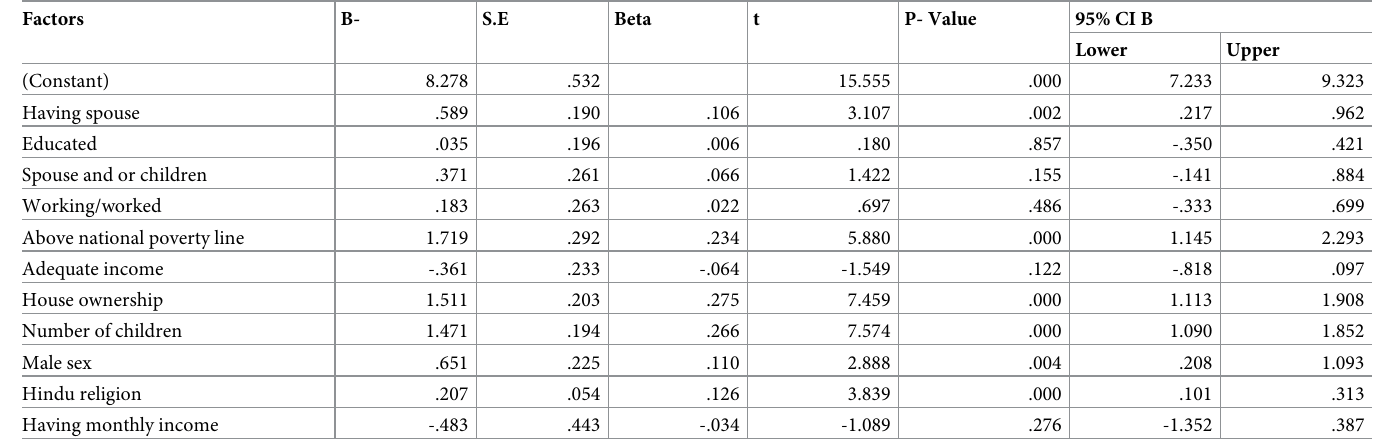
Table 6. Contributing factors of environmental domain of the QOL of